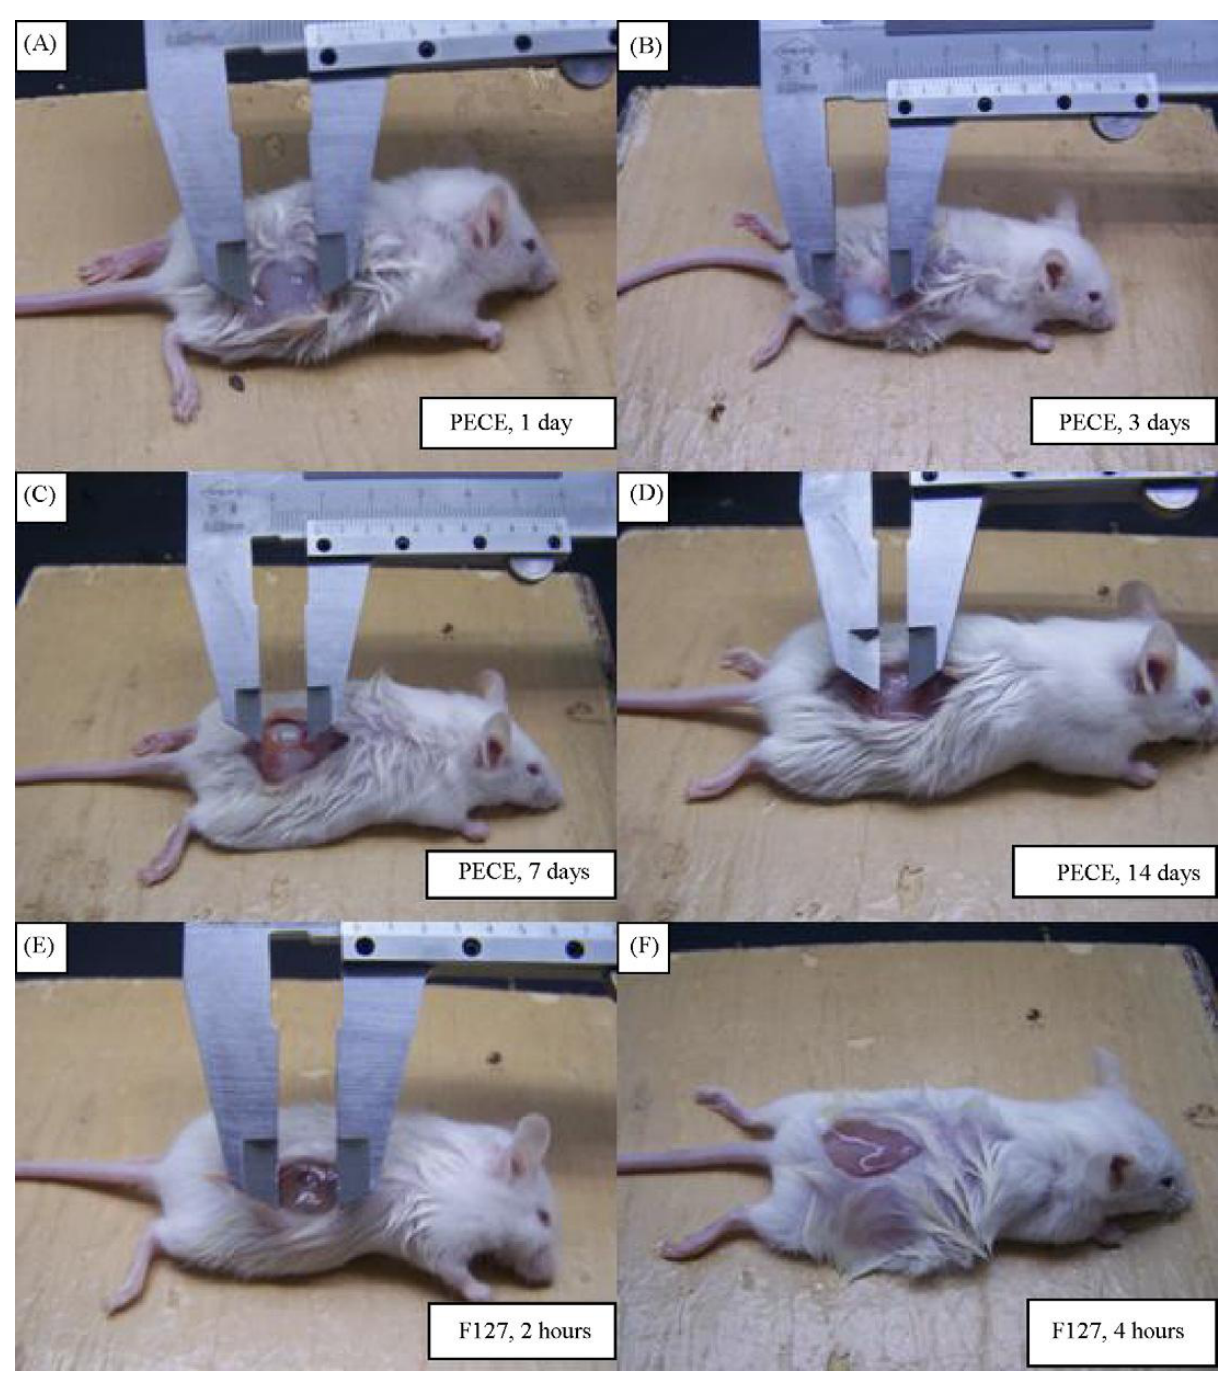
Figure 5. Gel formation and degradation behavior of PCL-PEG-PCL hydrogel according to reference